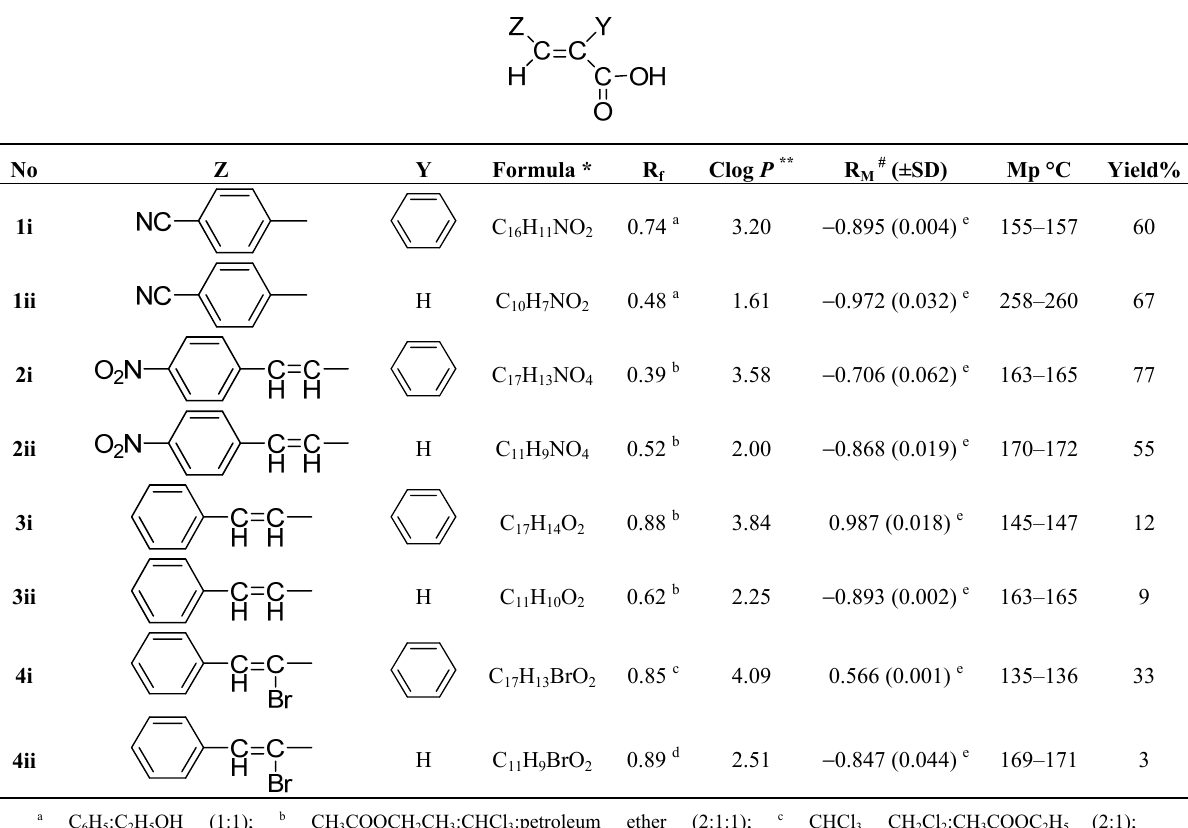
Table 1. Chemical structures, physicochemical and reaction data of cinnamic acid derivatives 1 –